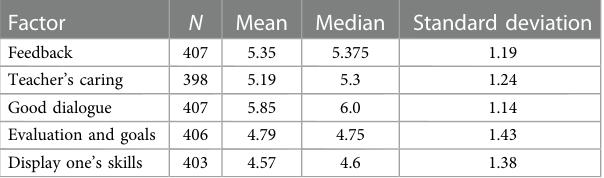
TABLE 3 Descriptive statistics for the fi ve